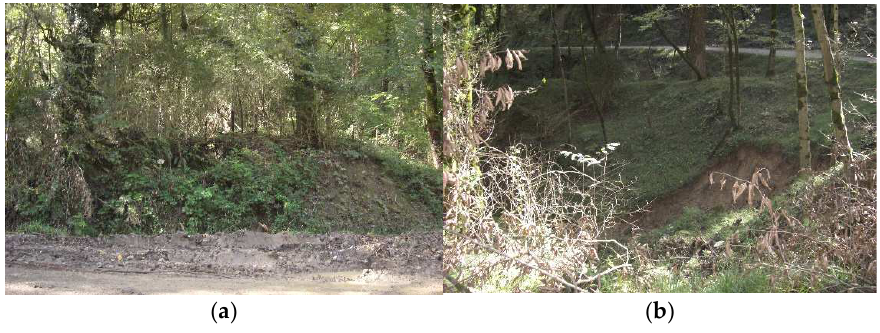
Figure 2. Landslides photos including: ( a ) cut slop; ( b ) fill slope.